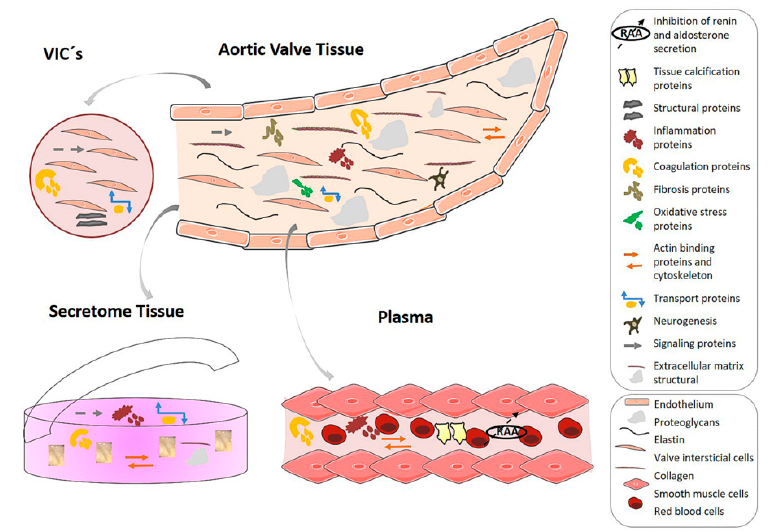
Figure 1. Processes involved in aortic stenosis development. Mechanisms involved in the pathogenesis of aortic stenosis and functional implications of observed protein alterations related to tissue calcification, structural, inflammation, coagulation, fibrosis, oxidative stress, actin binding and cytoskeleton, transport, neurogenesis, signaling, extracellular matrix modulation, and inhibition of renin and aldosterone secretion. The figure shows the four types of samples described in this review: valvular interstitial cells (VICs) and aortic valve tissue (on the top); secretome and plasma (on the bottom).